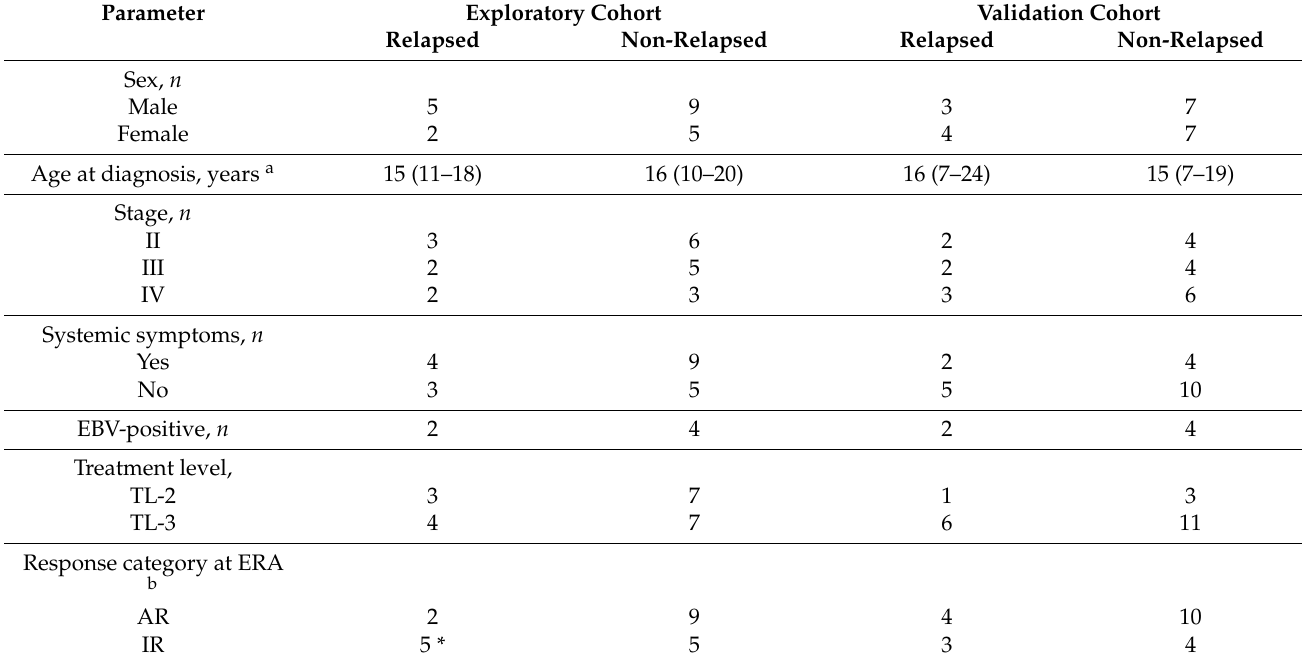
Table 1. Patients’ characteristics by disease status (relapsed vs. non-relapsed) after first-line treatment.